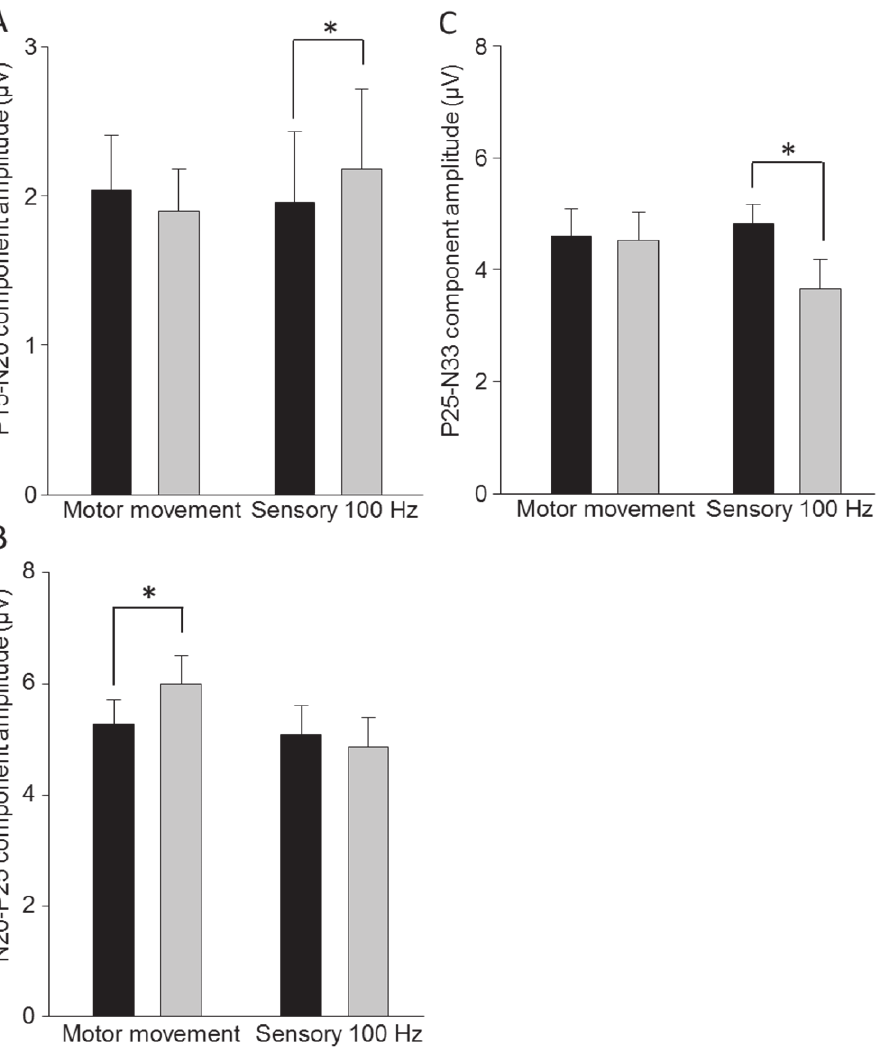
Figure 3. Group data (mean ± standard error) before (black bars) and after (grey bars) Motor Movement and Sensory 100 Hz peripheral electrical stimulation (PES) to the right abductor pollicis brevis muscle (APB) for the SEP components (a) P 14 -N 20 , (b) N 20 - P 25 and (c) P 25 -N 33 . Motor Movement PES increased the amplitude of the N 20 -P 25 component. Sensory 100 Hz PES increased the amplitude of the sub-cortical P 14 -N 20, and reduced the size of the P 25 -N 33 component. * p , 0.05.